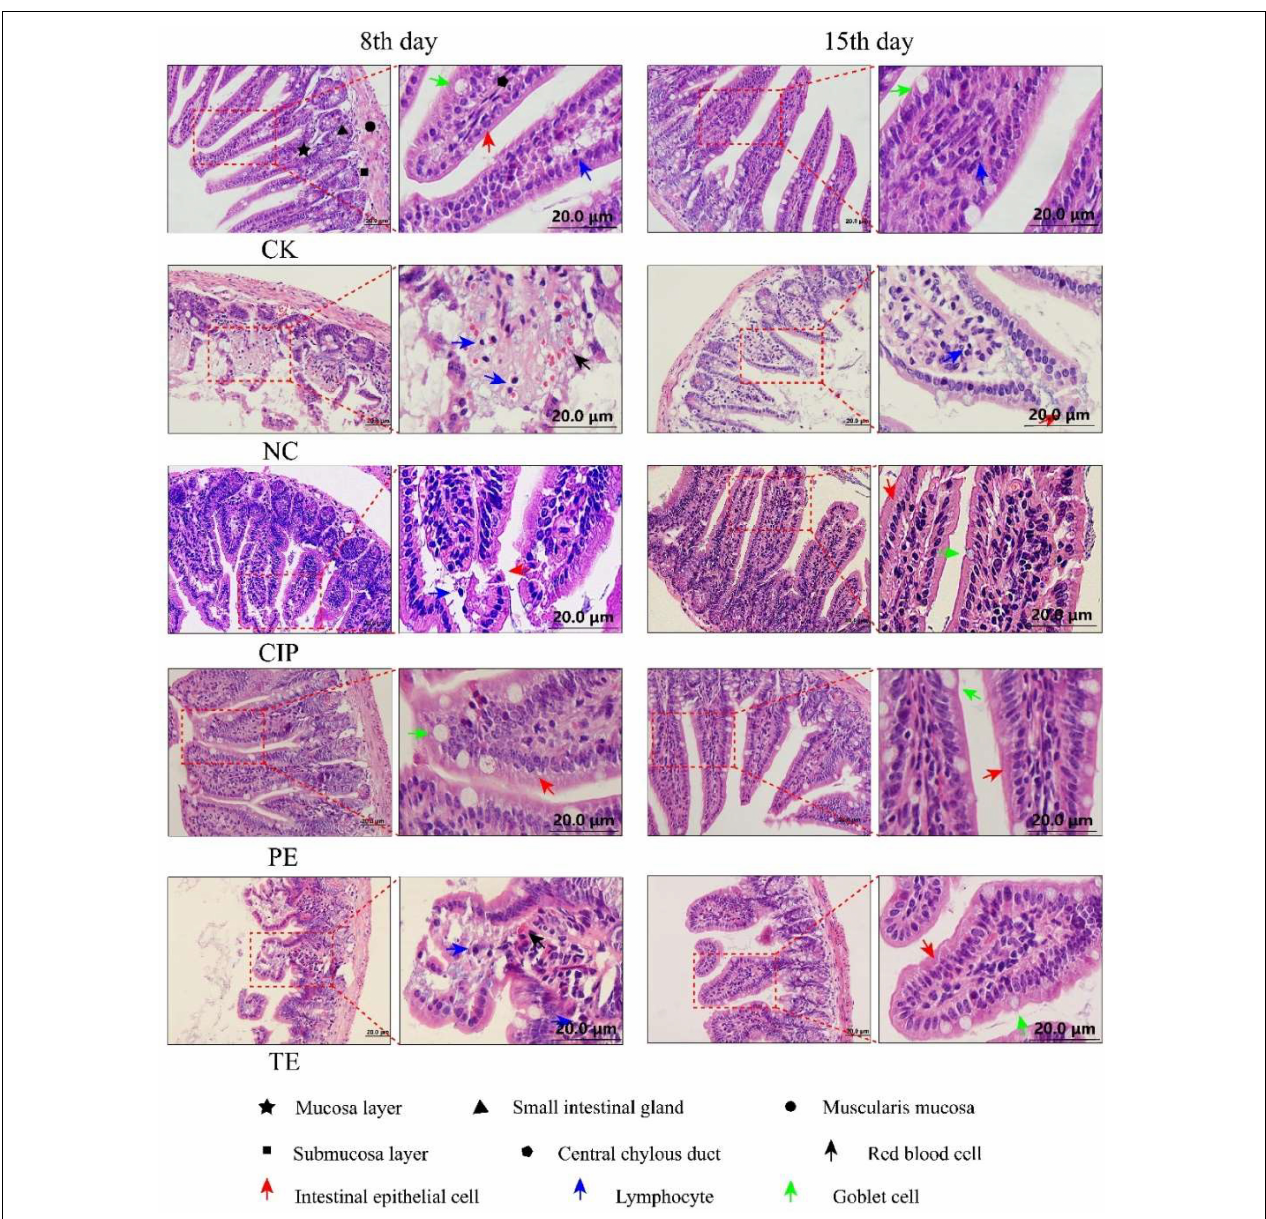
FIGURE 3 | Representative H&E staining microscopic images of ileum tissues from different groups. CK, the normal group; NC, the negative group; CIP, the diarrhea model group treated with ciprofloxacin; PE, the diarrhea model group prevented with L. paracasei ; TE, the diarrhea model group treated with L. paracasei.